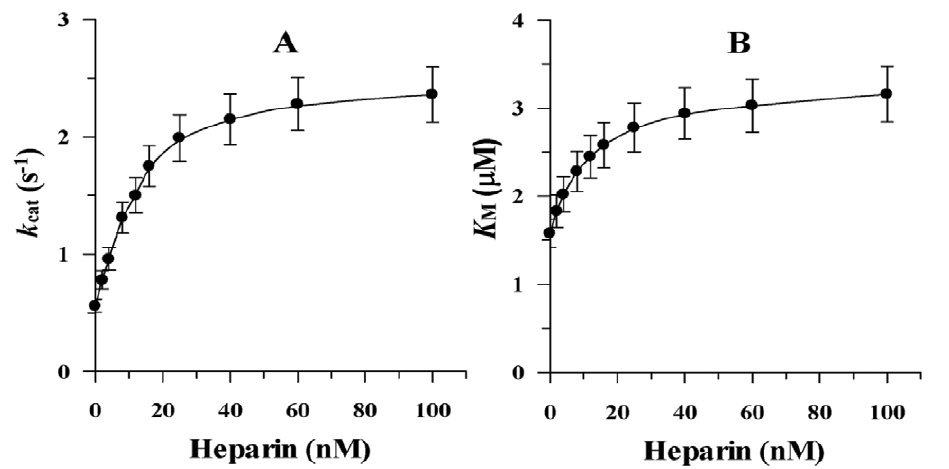
Figure 2. The effect of heparin on steady-state FRET-peptide hydrolysis by HNE. The influence of heparin concentration upon steady-state HNE kinetics parameters k cat [A] and K M [B] was determined spectrofluometricallyas described under ‘‘Experimental Procedures’’. The fluorescence increase of FRET-peptide hydrolysis (0.2 - 10 m M) by 12.6 nM HNE were performed in 10 mM Hepes, pH 7.4, containing 140 mM NaCl and 0,05% Triton X-100 at 37 u C.